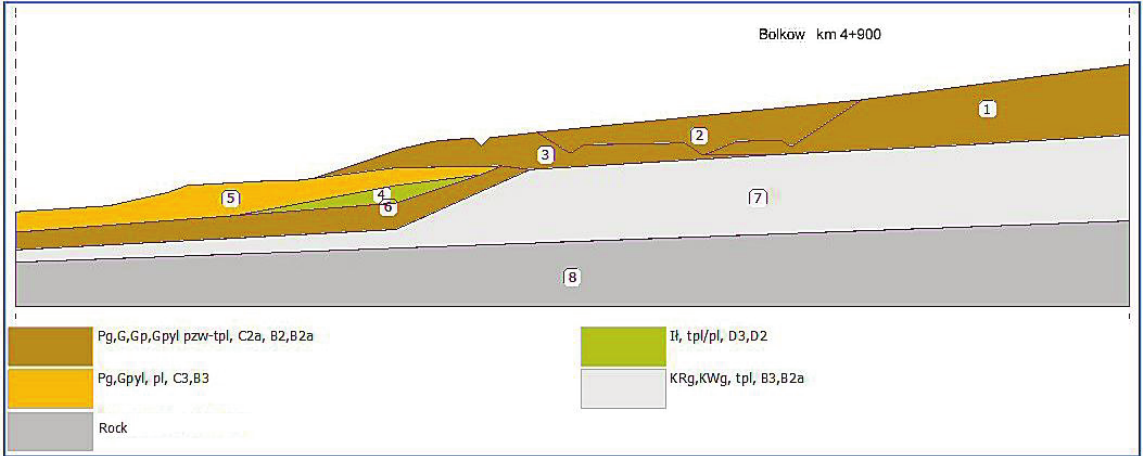
Figure 8. System of ground layers. Phase 1 of calculations – state before performance of a road excavation.